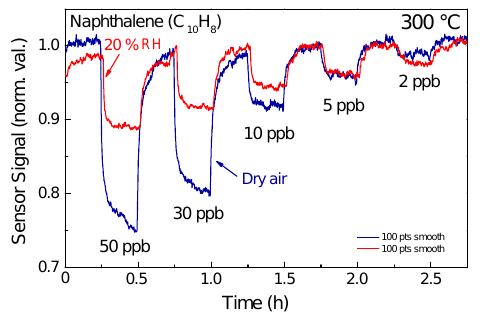
Figure 4. Sensor response to different concentrations of naphtha- lene (C 10 H 8 ) from 50 to 2ppb at 300 ◦ C in dry air and under 20% relative humidity (RH). The sensor signals are filtered to reduce the electronic noise. The value 100pts smooth is equivalent to a sam- pling time of 100ms.